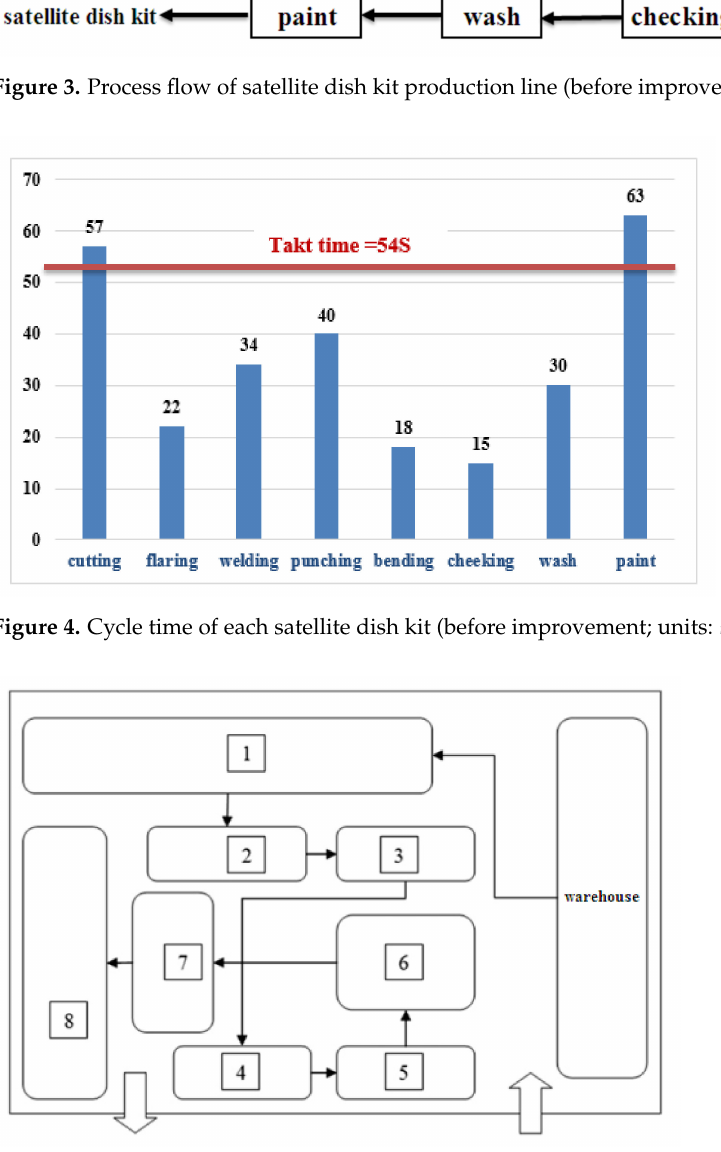
Figure 5. Initial layout of satellite dish kit production line (before